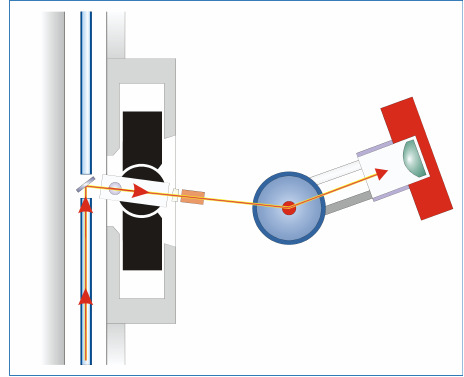
Figure 2: Schematic view of